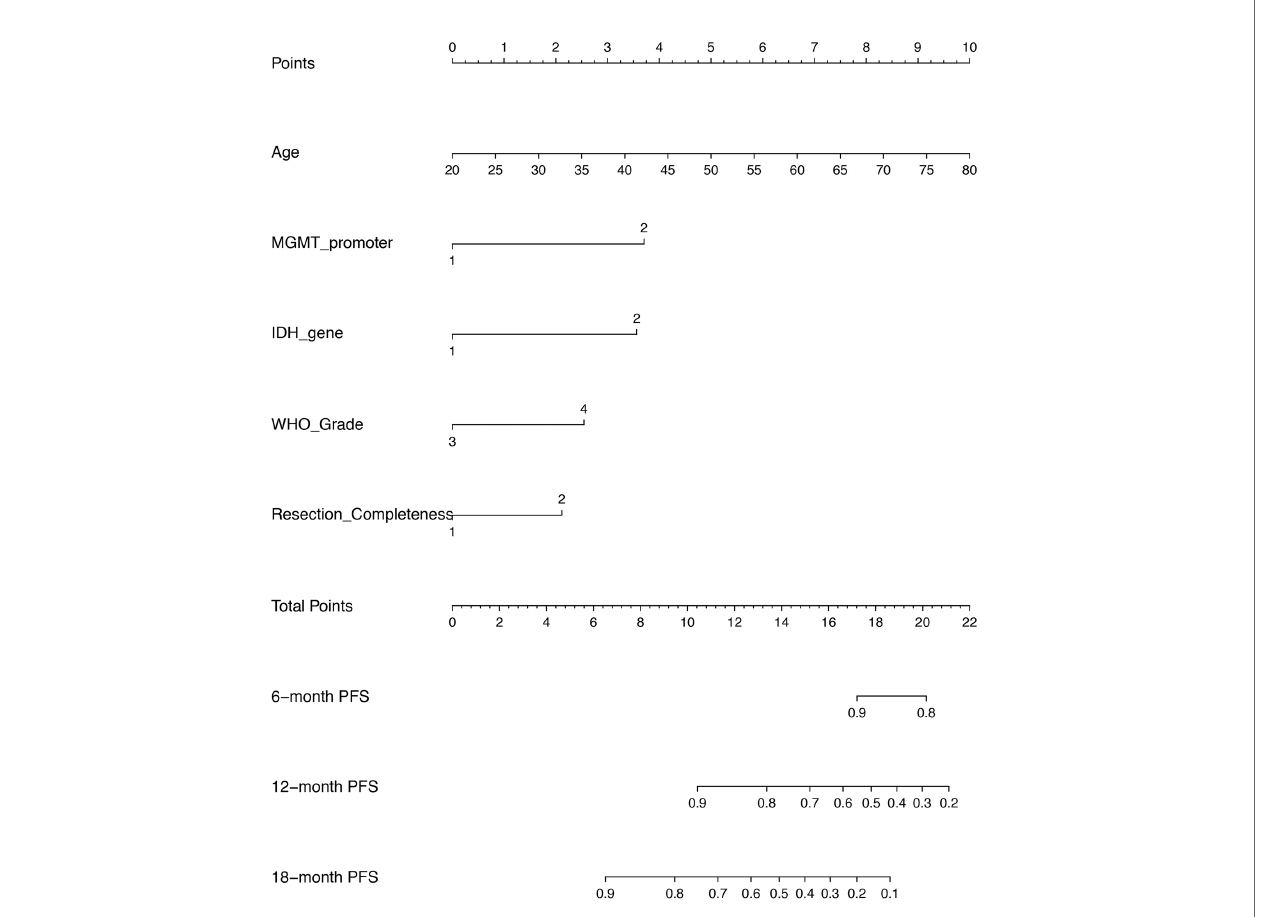
FIGURE 5 | A nomogram of predicting the probability of 6 month-, 12 month-, and 18 month- progression free survival (PFS) at personnel level. The scores of each variable are as follows: age (years) presented as continuous value, MGMT promoter (1 = methylation, 2 = unmethylation/not known), IDH gene (1 = mutant, 2 = wild), WHO grade (3 = Grade III, 4 = Grade IV), resection completeness (1 = gross total resection, 2 = non gross total